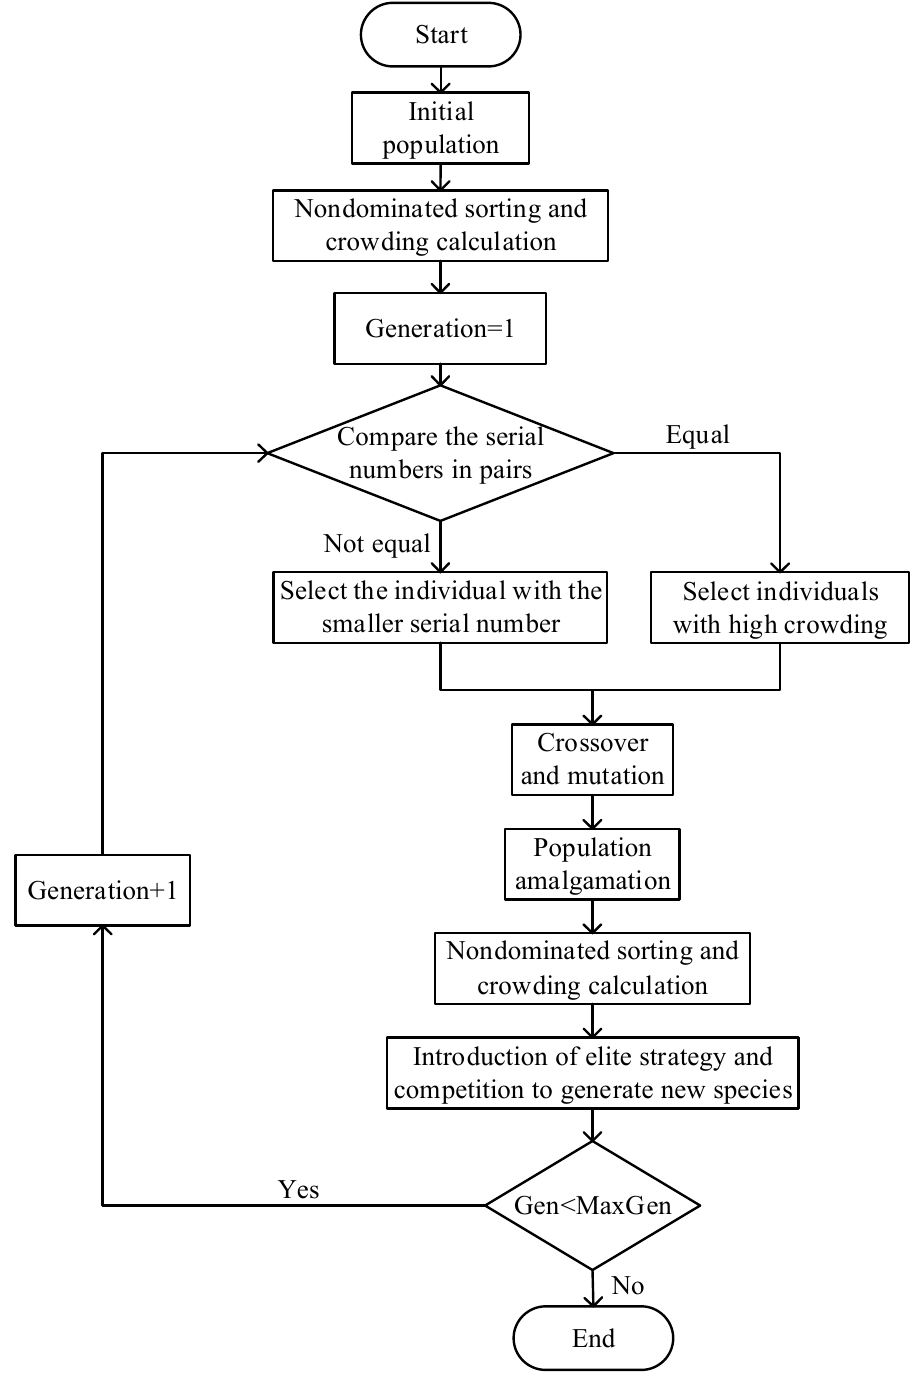
Figure 6. Optimization process of Non-Dominated Sorting Genetic Algorithm II (NSGA-II).